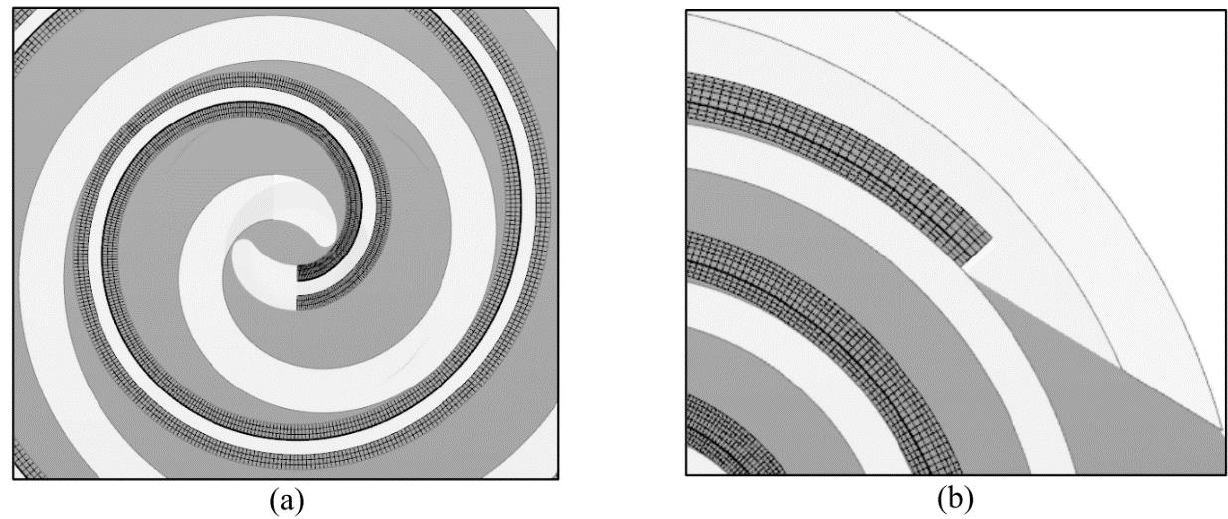
Figure 5. Example of tip seal volumes in a scroll compressor: ( a ) end of the tip seal volumes; ( b ) start of the tip seal vol-umes.